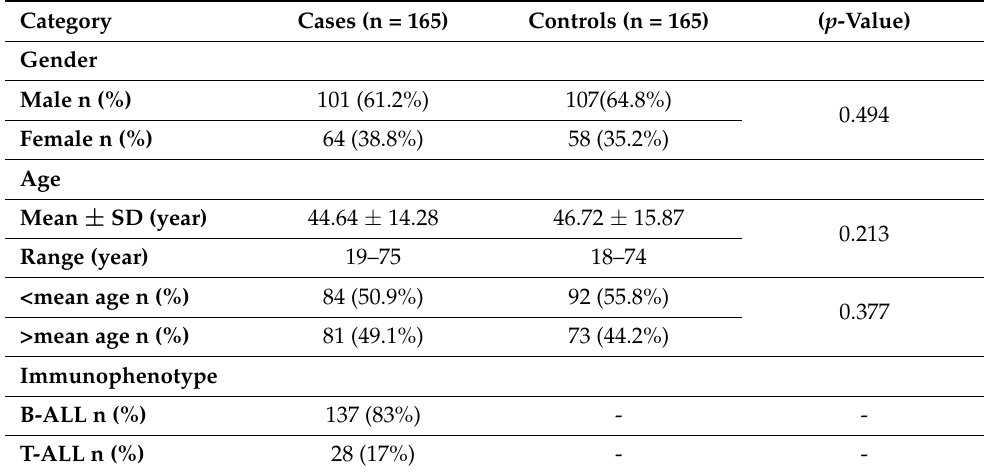
Table 1. Demographic measures of the studied